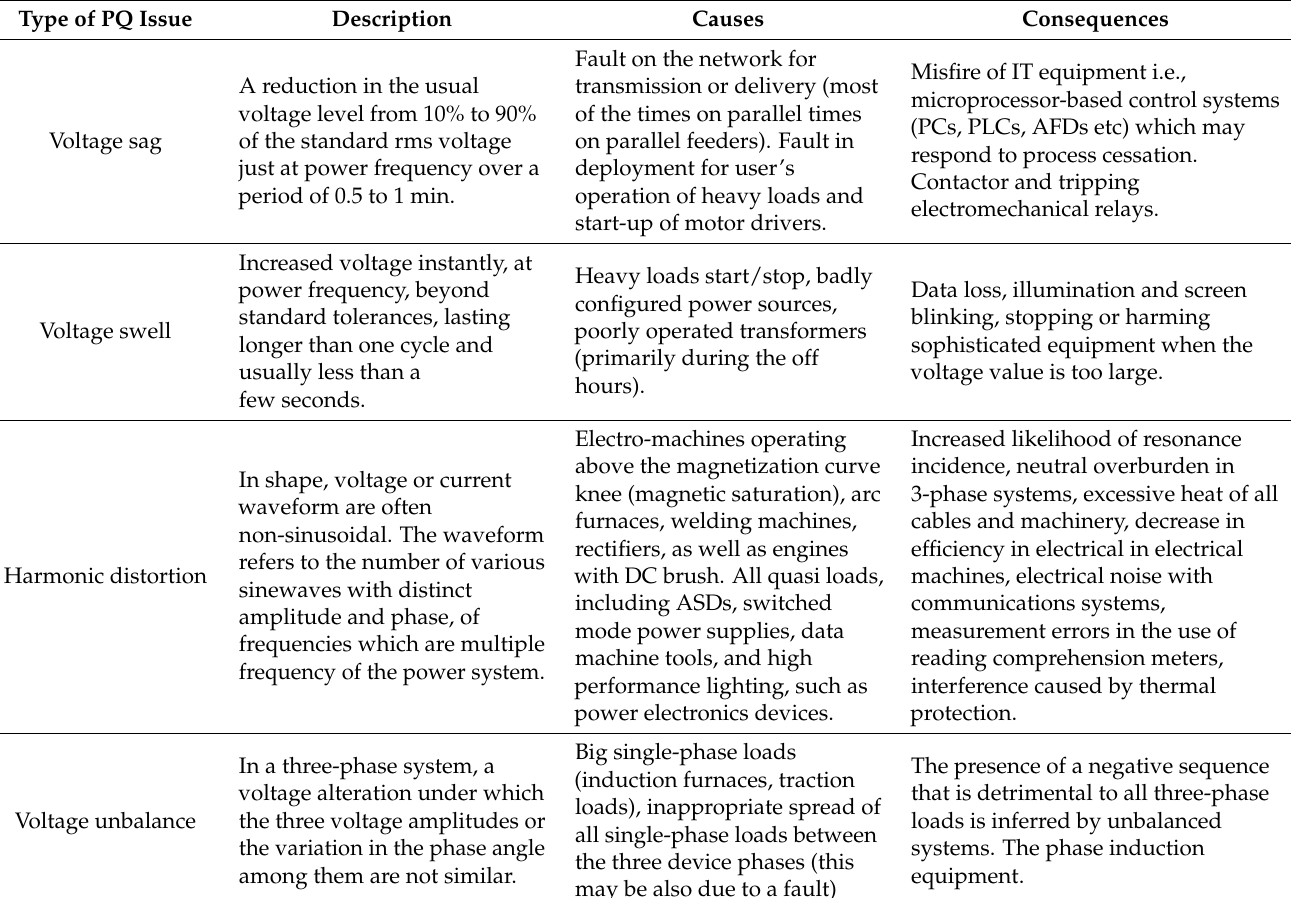
Table 1. PQ Issues, causes and